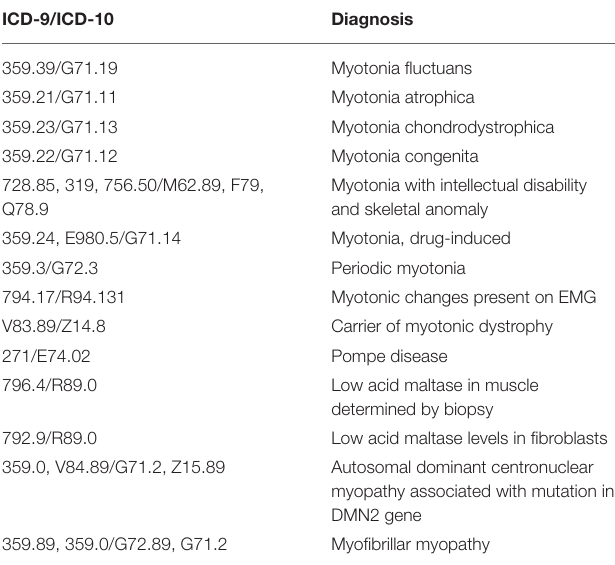
TABLE 1 | List of diagnostic codes utilized in the search for candidates meeting inclusion criteria.